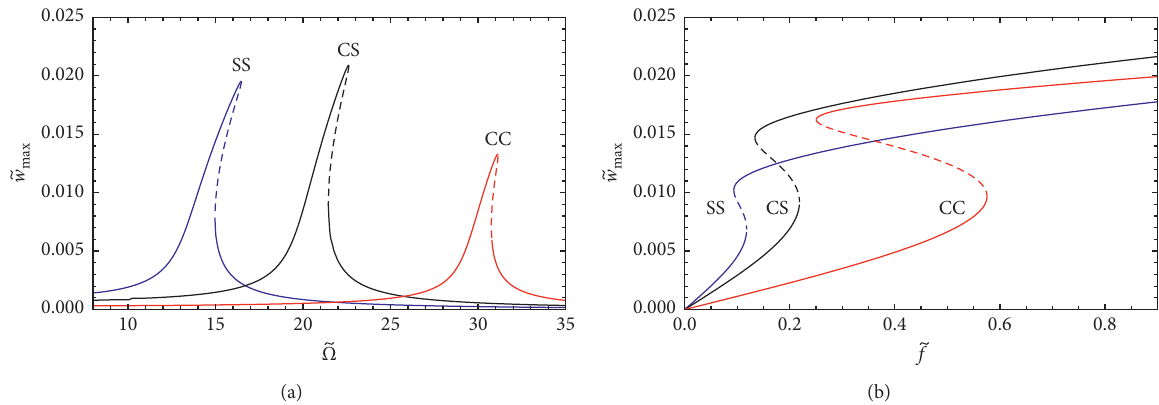
Figure 14: The response curves of transverse motion of BDFG porous beam with different end supports when m � c � 0 . 05. (a) Frequency-response curves with 􏽥 f � 0 . 2. (b) Force-response curves with 􏽥 Ω � 1 . 05 􏽥 ω L / h � 20, and c d r